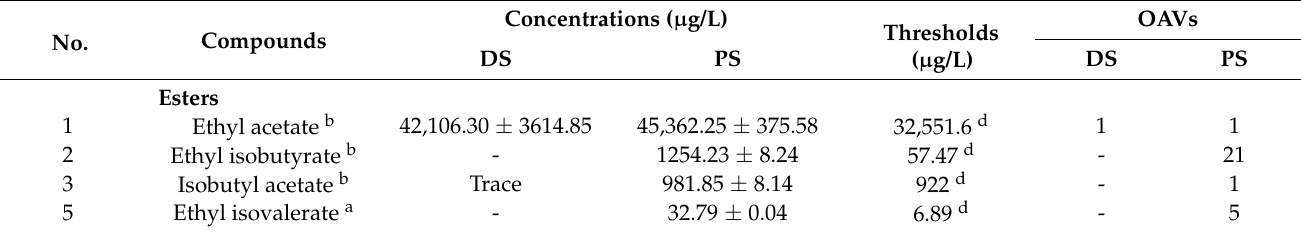
Table 2. Quantification parameters, concentration, odor thresholds and OAVs of aroma compounds in peach